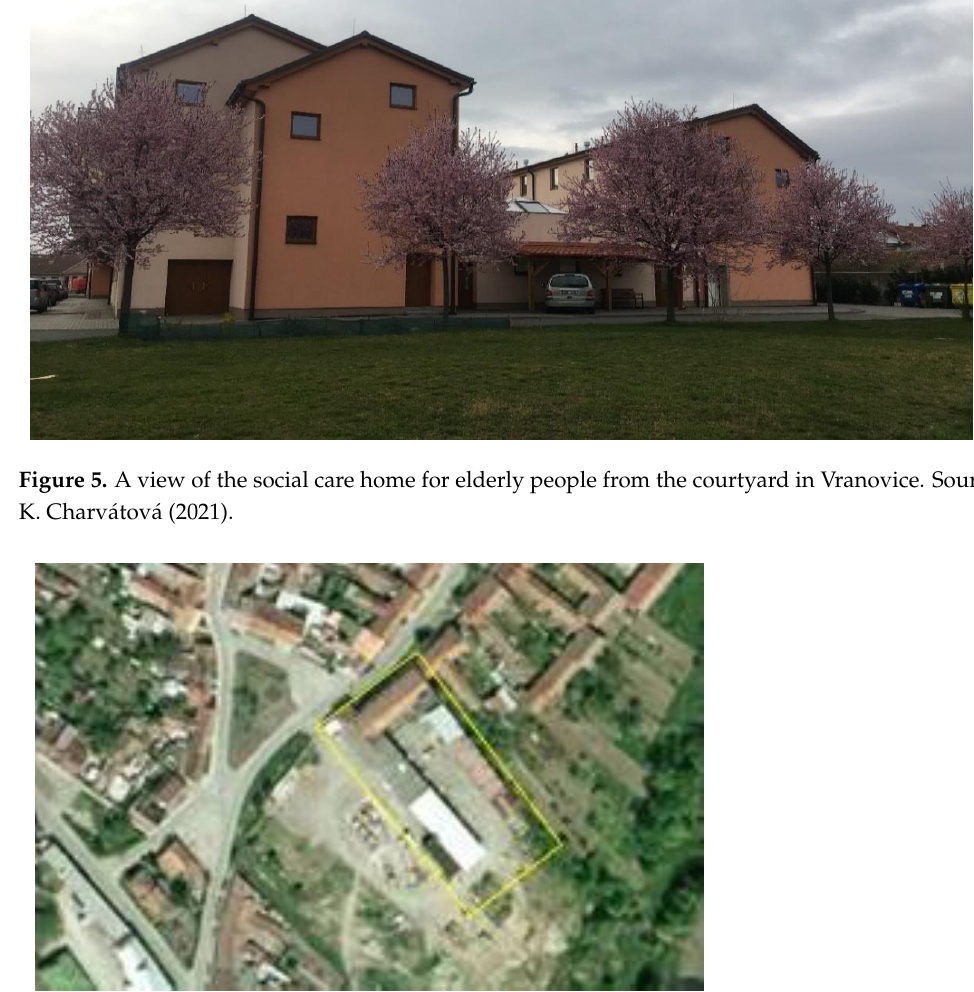
Figure 6. Aerial views of the site of a former agricultural cooperative in Vranovice before regeneration in 2003. Source: [60].